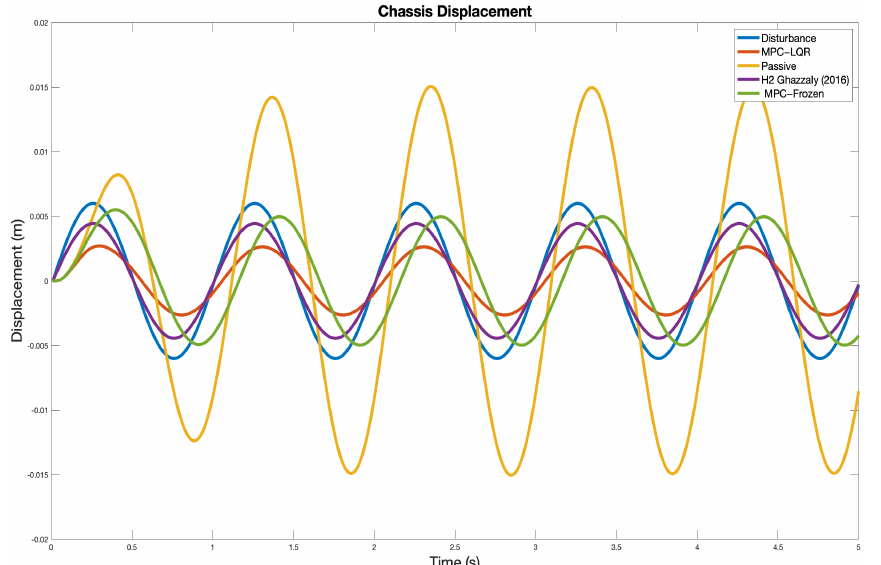
Figure 10. Chassis displacement—Sinusoidal Disturbance (Blue—disturbance, Red—MPC-LQR, Yellow—Passive, Purple—H2, Green—MPC-Frozen).